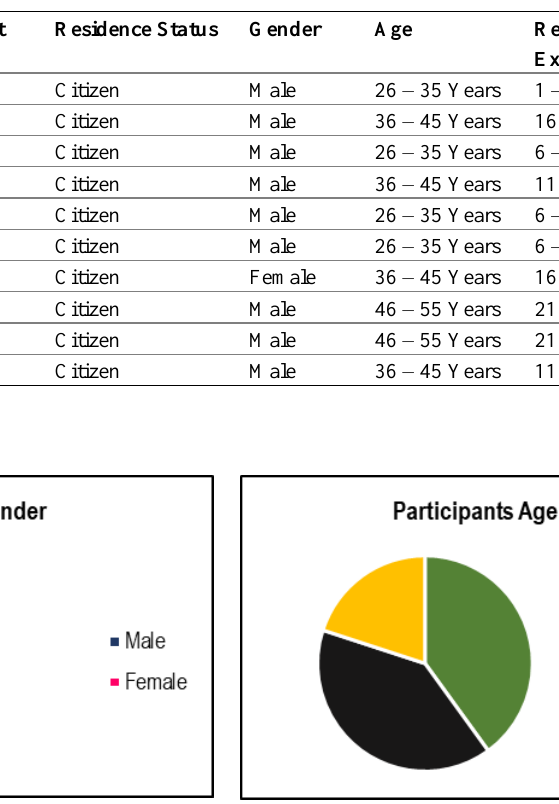
Figure 2: Participants Gender Figure 3: Participants Age Composition